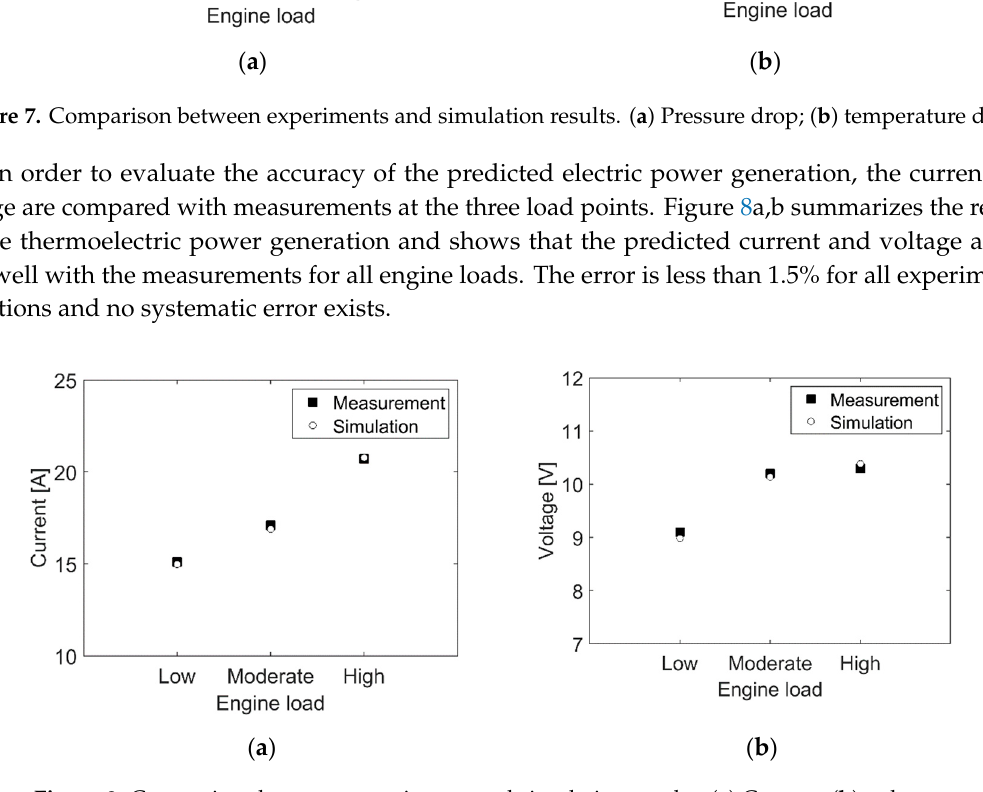
Figure 8. Comparison between experiments and simulation results. ( a ) Current; ( b ) voltage.